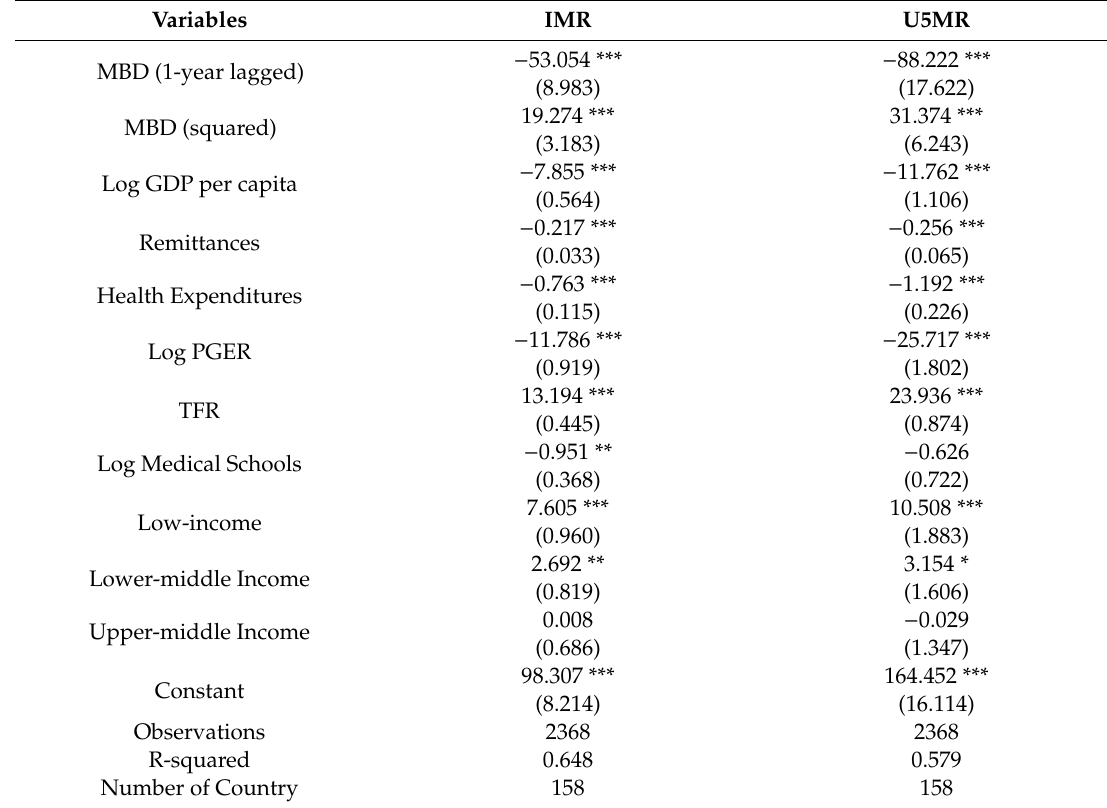
Table 8. Fixed-e ff ects regression of MBD (1-year lagged) on IMR and U5MR in 158 countries (excluding major destination countries) over